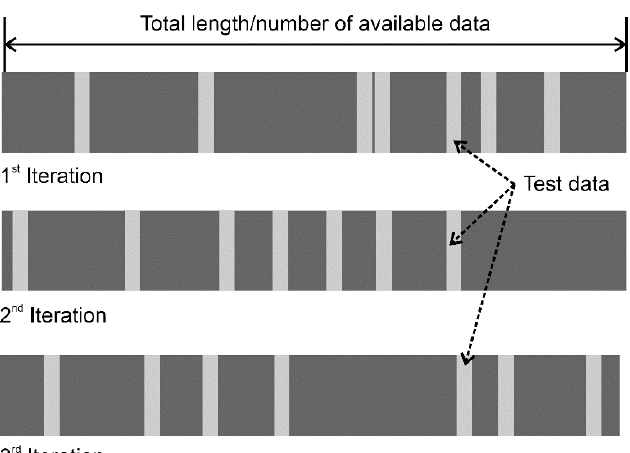
Figure 9. Random subsampling validation method to reduce bias in the learning data by randomly extracting validation data for each iteration, thereby preventing underfitting and overfitting.